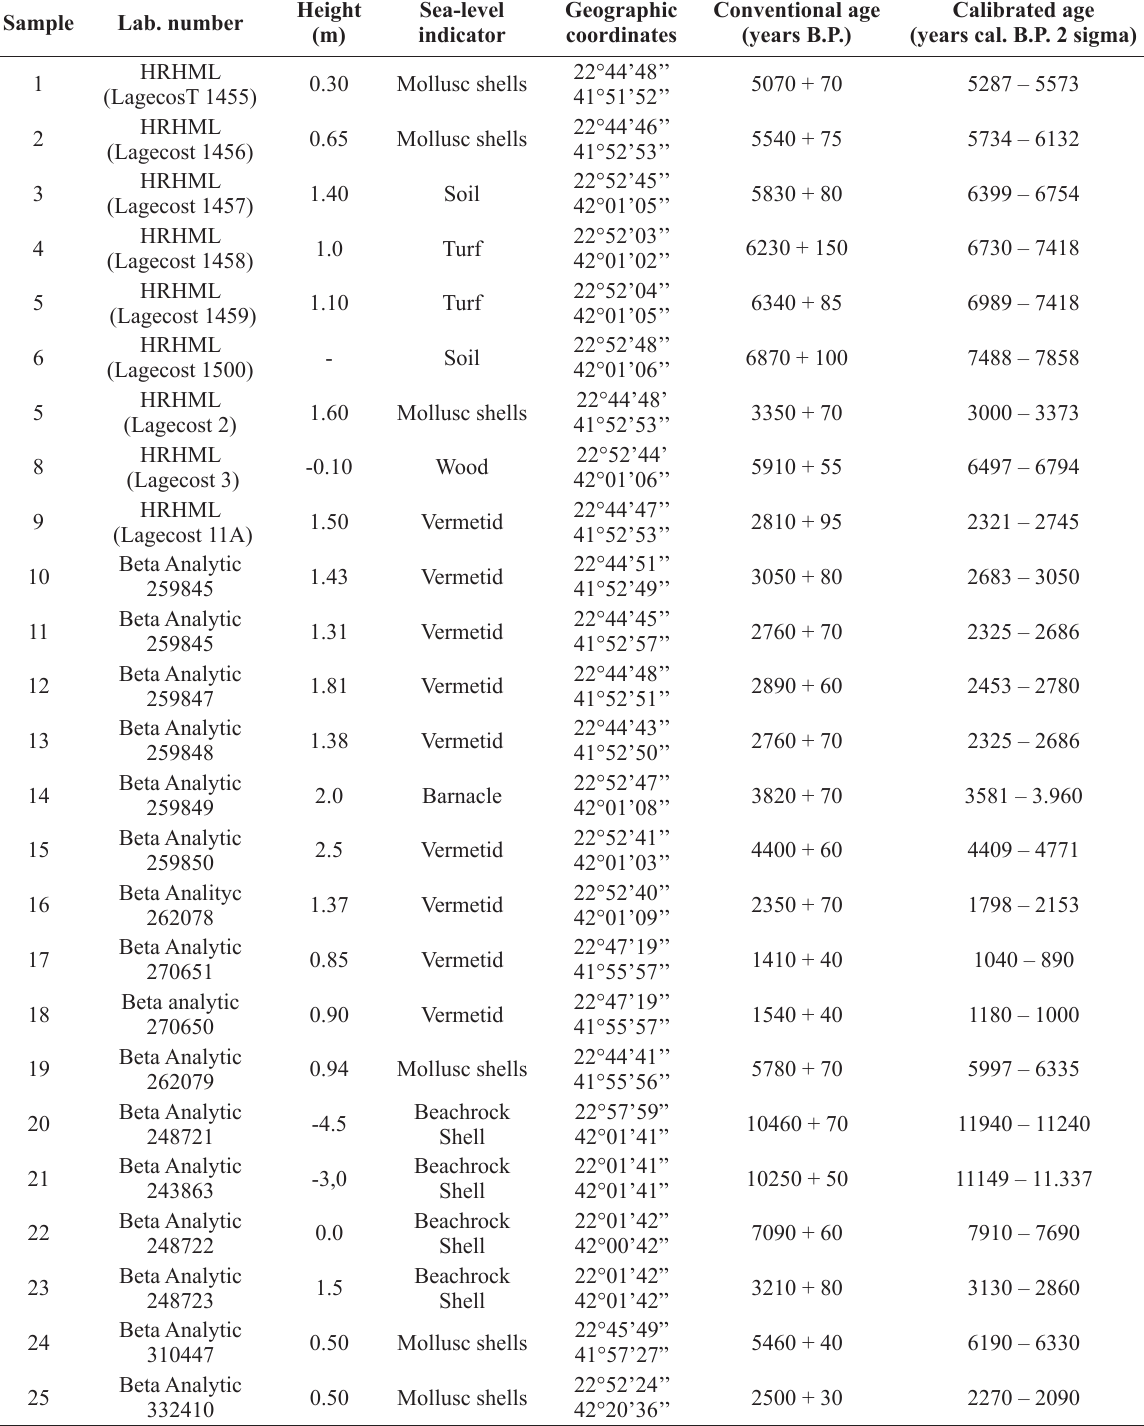
Calibrated ages by 14 C dating of the twenty nine samples obtained on the coast of the state of Rio de Janeiro in southeastern